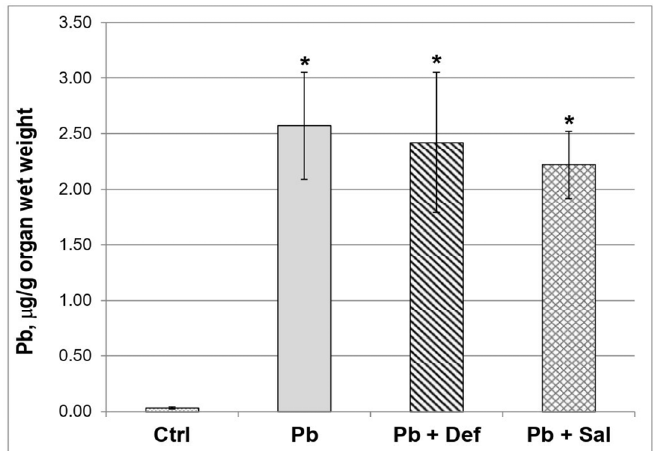
Figure 1. Comparative effect of deferiprone and salinomycin on the Pb content in kidneys of Pb-intoxicated mice, n = 6. Legend: ctrl—untreated mice; Pb—Pb-exposed group; Pb + Def—Pb-intoxicated mice, treated with deferiprone; Pb + Sal—Pb-intoxicated mice, treated with salinomycin. Asterisk denotes a significant difference compared to the untreated control group, p < 0.05.